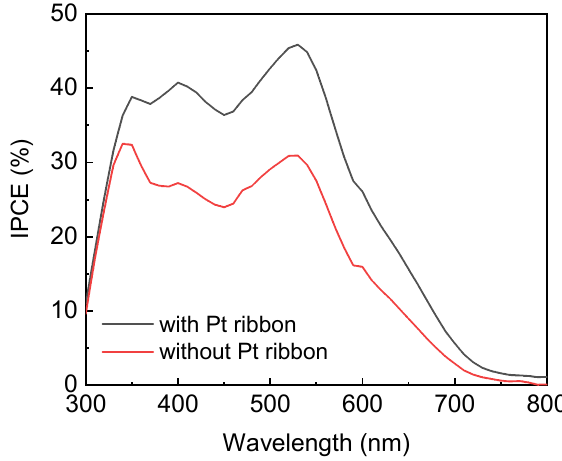
Figure 7. IPCE spectra of DSSCs with and without a Pt ribbon. The electrochemical impedance spectra of the DSSCs with and without a Pt ribbon were obtained from a ZIVE SP1 impedance analyzer (WonATech, Seoul, Republic of Korea) at a bias voltage of 10 mV and a solar intensity of 100 mW/cm 2 . Figure 8a,b displays the Nyquist and Bode plots of the DSSCs with and without a Pt ribbon.